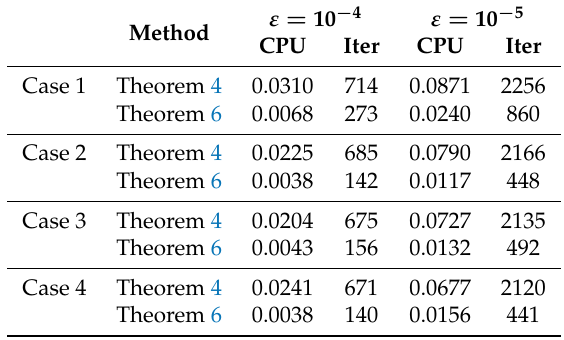
Table 2. Comparing results for Theorems 4 and 6 for each